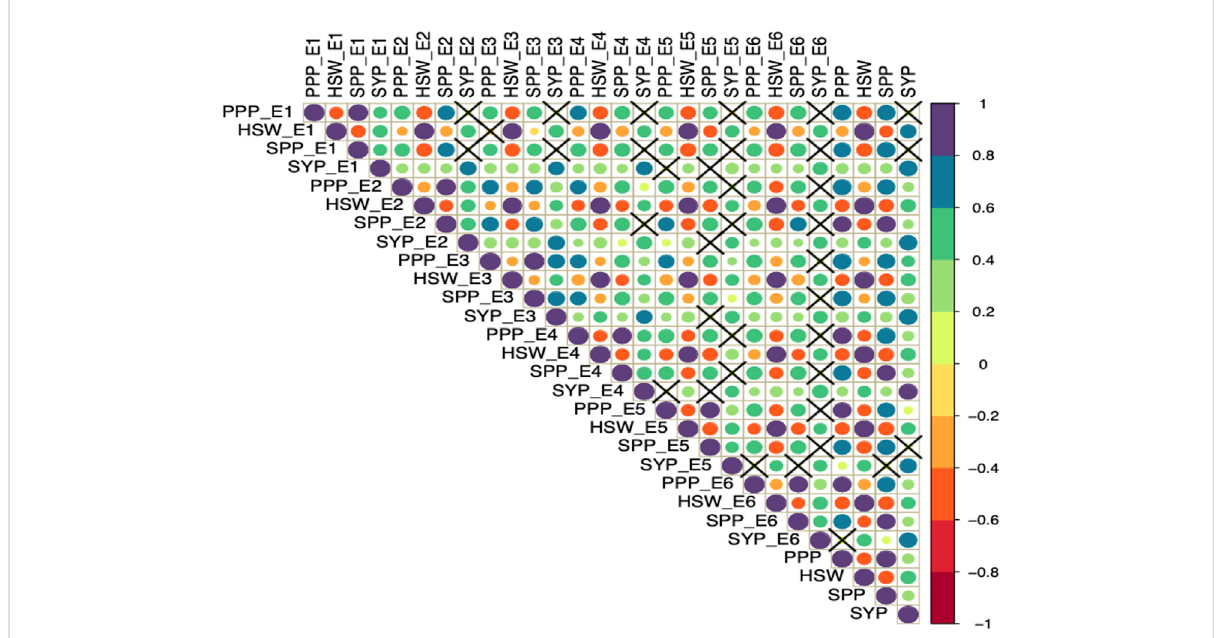
FIGURE 1 Pearsoncorrelationanalysis ofyield andyield-relatedtraitsevaluatedacrossdiverseenvironments.Thefourtraitsincludingseed yieldperplant (SYP), numberofpodsperplant(PPP), numberofseeds perplant(SPP),and100-seedweightingrams (HSW)wereevaluated insixenvironments(E1, E2, E3, E4, E5, and E6) and the combined environment. The color and size of the circle re fl ect the strength of correlation. The non-signi fi cant correlations ( p > 0.05) are indicated with a cross in individual